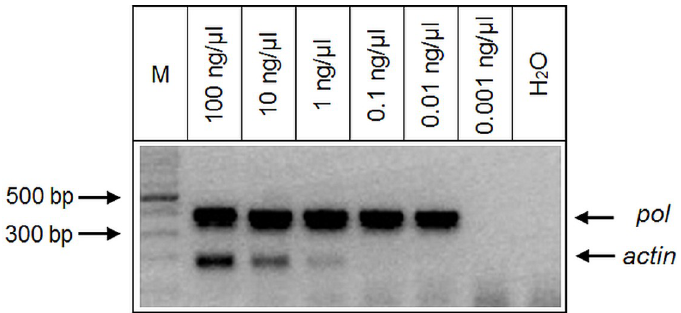
Fig 2. Sensitivity of the multiplex n-PCR. Serial dilutions (1/10) of the DNA obtained from the MT2 cell line, from 100 ng/ μ l to 0.001 ng/ μ l, H 2 O (negative control). In each case, the amplification was made with 5ul of DNA from each dilution. The arrows point to the band of pol and actin amplification and 100 bp DNA Ladder (M).